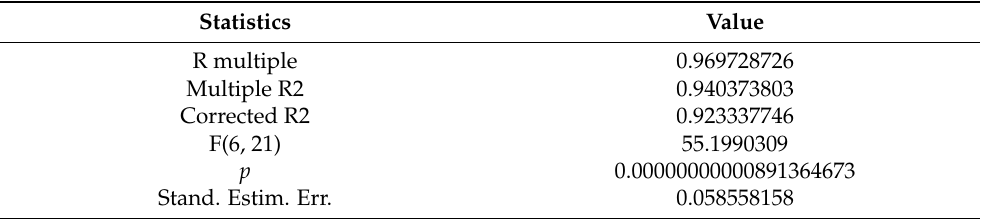
Table 10. Summary of the linear regression of dependent variable